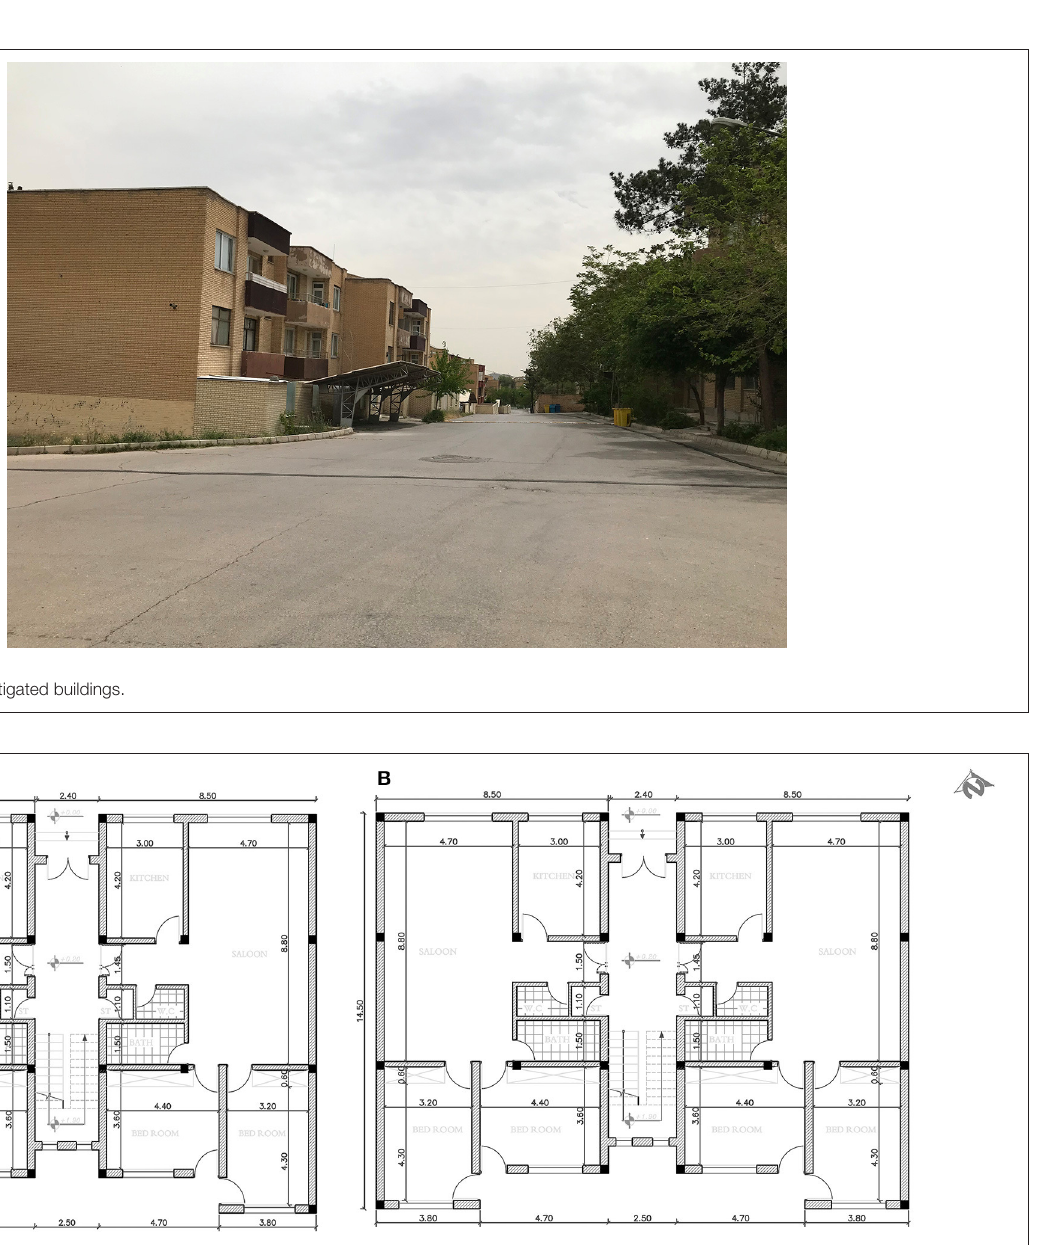
FIGURE 4 | Typical floor plans of the blocks; left to right: (A) Ground floor plan. (B) First and second-floor